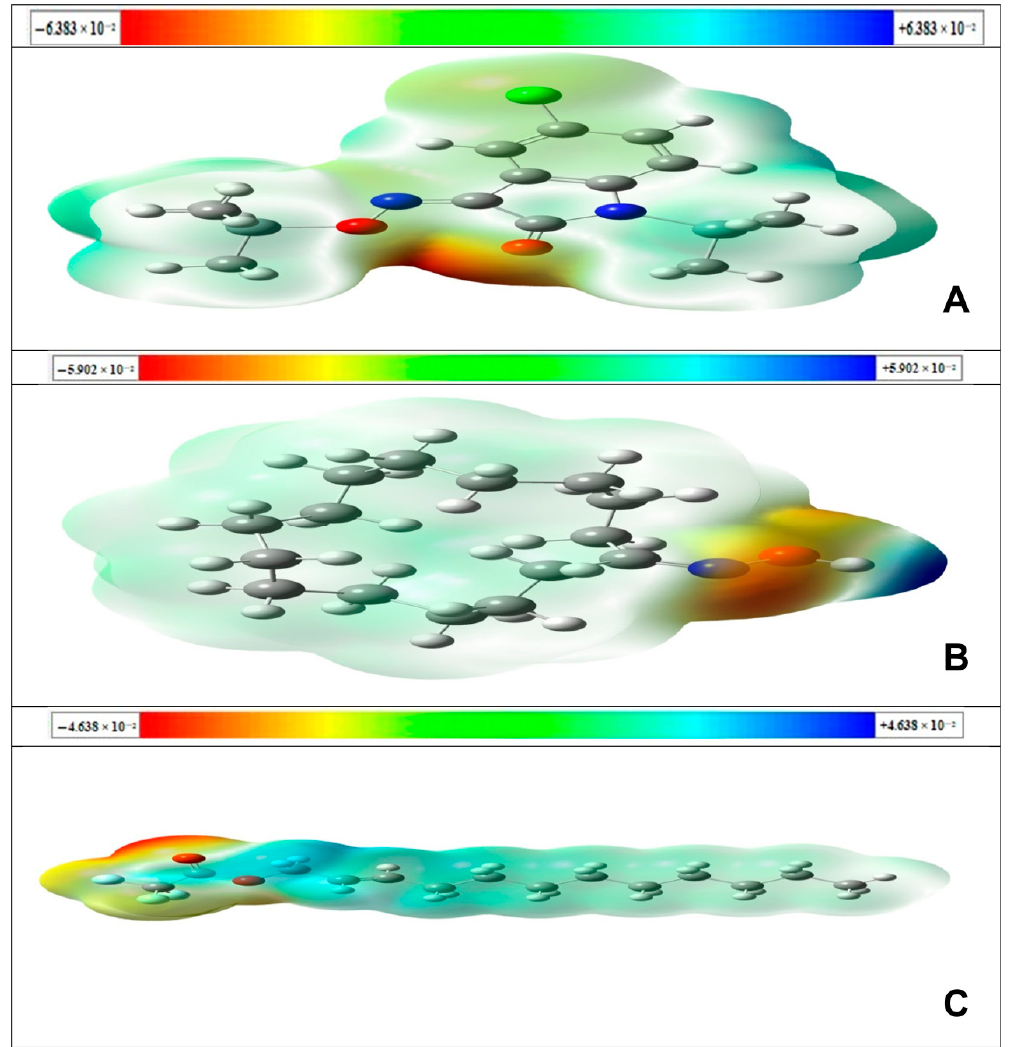
Figure 4. Calculated 3D surface mapped of electrostatic potential for 5-chloro-1-(trimethylsilyl)-1 H -indole-2,3-dione 3-[O-(trimethylsilyl)oxime] ( A ); cyclopentadecanone oxime ( B ); trans -2-dodecen-1-ol trifluoroacetate ( C ), respectively in (a.u), the electron density isosurface being 0.0004 (a.u).